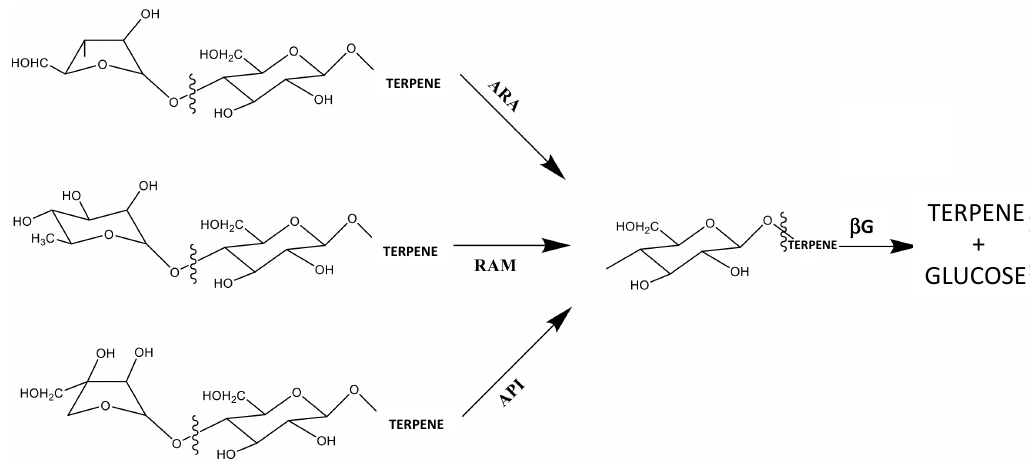
Scheme 1. Scheme of reactions involved in aroma release in wine.